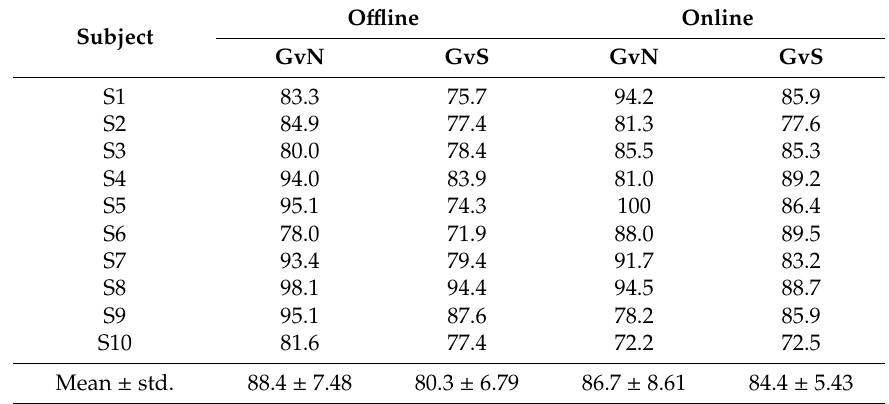
Table 3. Offline and online classification accuracy (%). Table 3. O ffl ine and online classification accuracy (%).